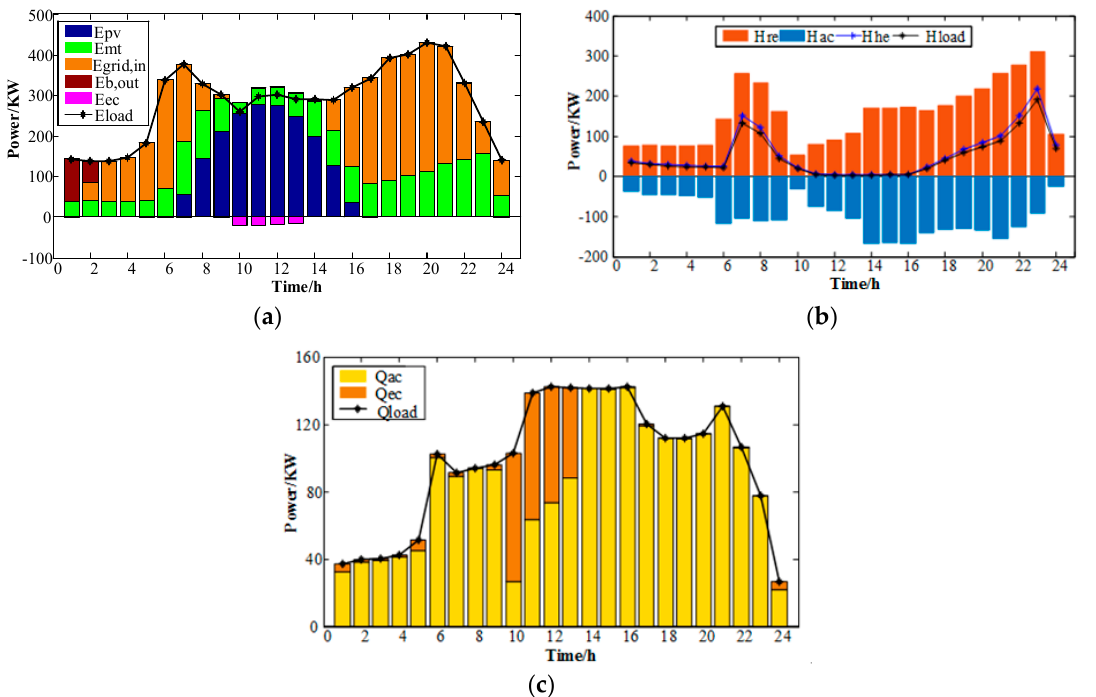
Figure 8. Power balance diagram under the IFEL strategy: ( a ) Electric load balance; ( b ) Heat load balance; ( c ) Cold load balance.